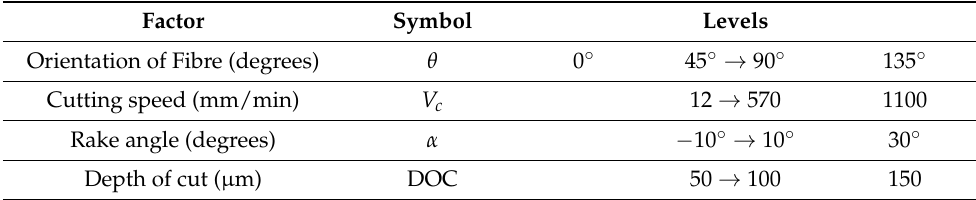
Table 2. Machining parameters applied to